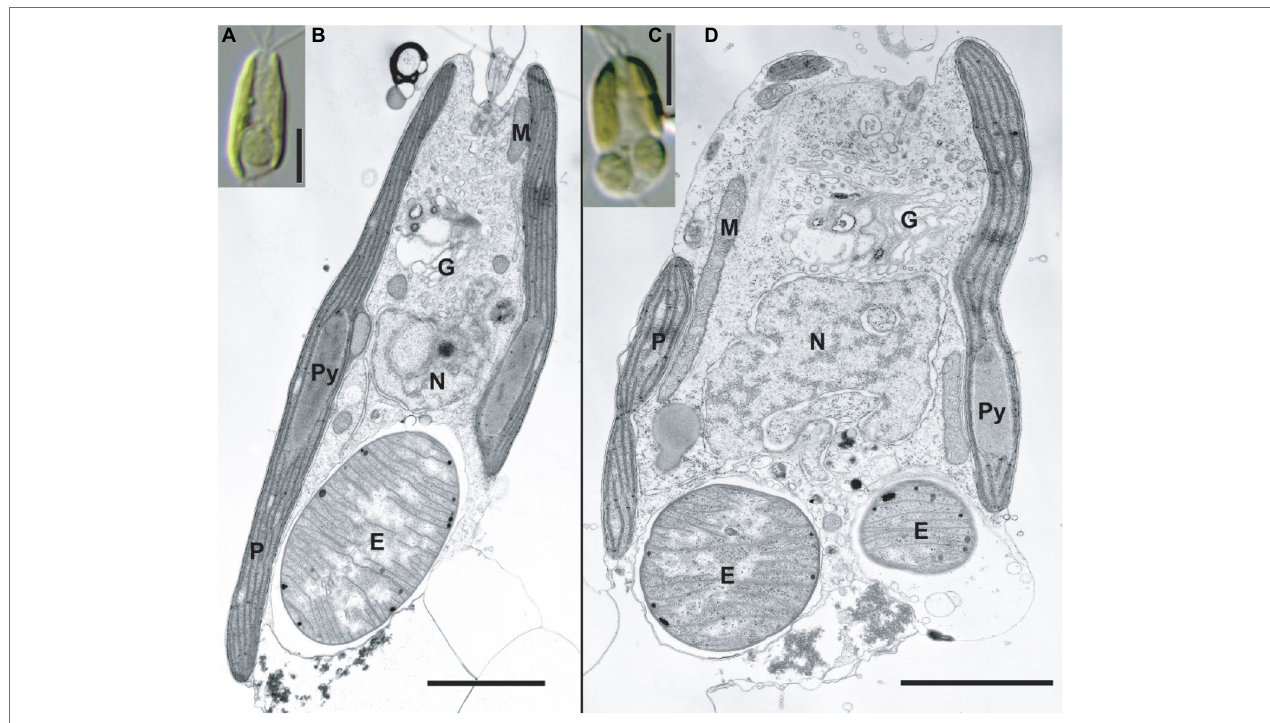
FIGURE 2 | TEM images of the C. parkeae stage of B. bigelowii . Light microscopy images (A , C) and corresponding TEM images are shown (B , D) for strain MK90- 06. Usually, one endosymbiont is found per cell in the posterior of the cell (A , B) ; however, some of the cells had two endosymbionts per cell during cell division (C , D) . Scale bars represent 5 μ m in (A and C) , and 2 μ m in (B and D) . E, endosymbiont; G, Golgi apparatus; M, mitochondrion; N, nucleus; P, plastid; and Py,